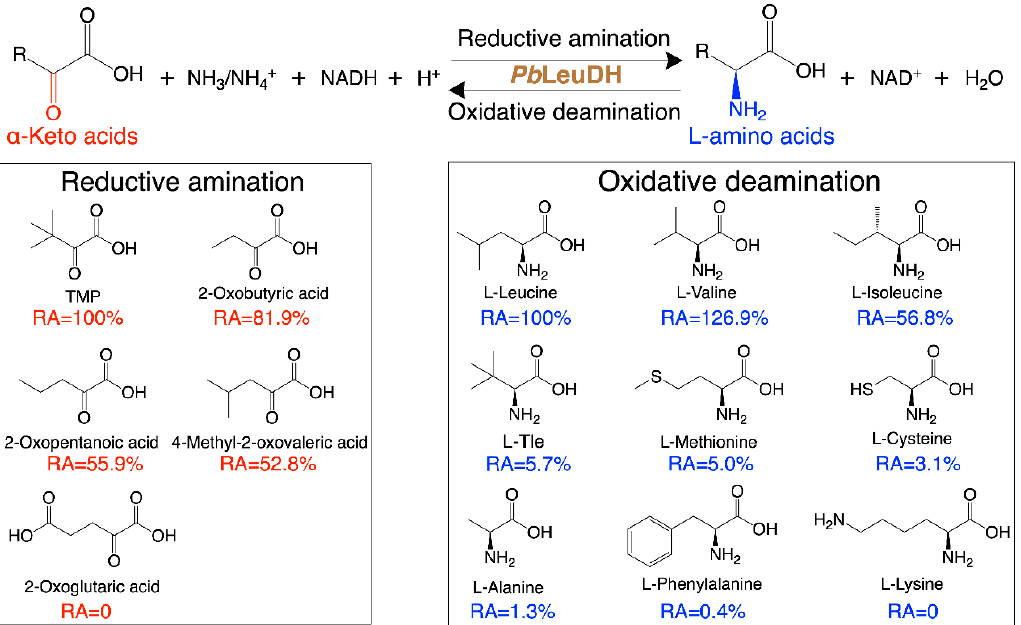
Figure 5. Substrate specificity of Pb LeuDH in reductive amination and oxidative deamination. The specific activities toward TMP (51.71 U mg − 1 ) and L-leucine (26.50 U mg − 1 ) were defined as 100% activity for reductive amination reaction and oxidative deamination reaction, respectively. RA, relative activity.